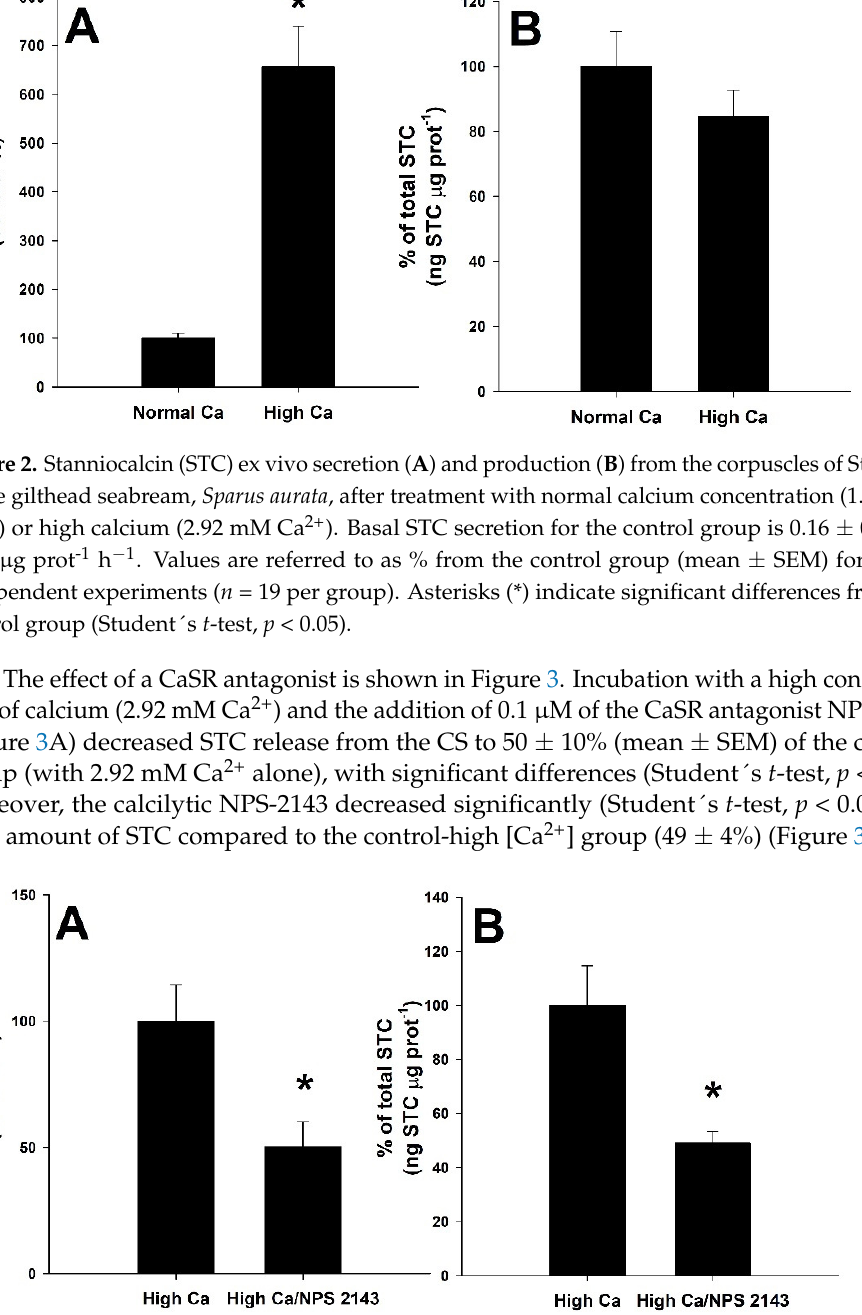
Figure 3. Stanniocalcin (STC) ex vivo secretion ( A ) and production ( B ) from the corpuscles of Stannius of the gilthead seabream, Sparus aurata , incubated with high calcium (2.92 mM Ca 2+ ) in the absence or presence of the CaSR antagonist 0.1 µ M NPS-2143. Values are presented as % of the control-high calcium Asterisks (*) indicate significant differences from the control group (Student ´ s t -test, p <